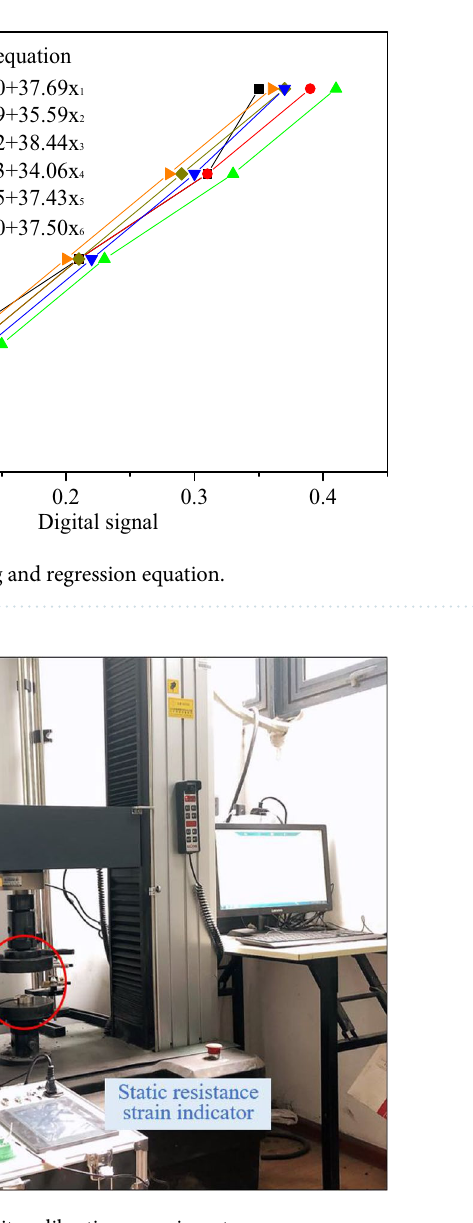
Figure 7. Force sensor and its calibration